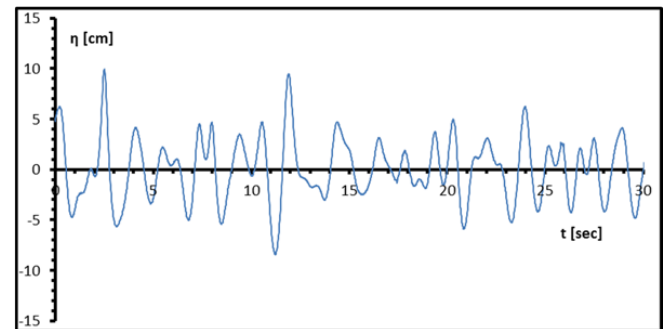
Figure 5. Water elevation η time series for Experiment #2.